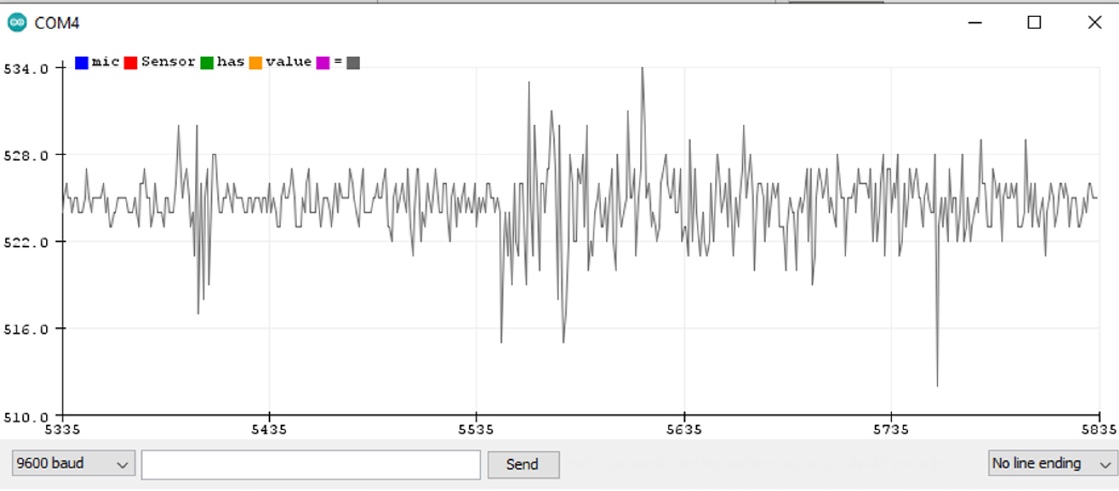
Figure 10. A passing vehicle’s waveform.